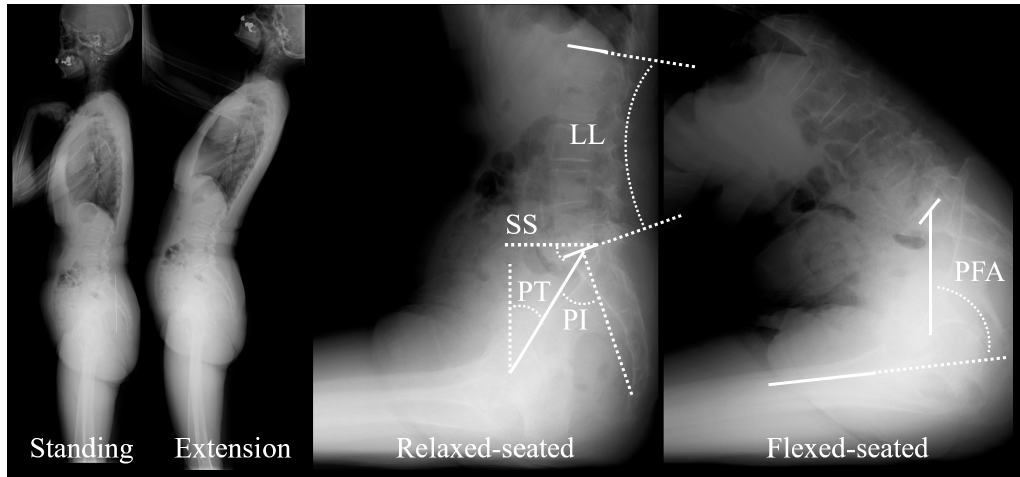
Figure 1. Lateral radiographs in free standing (Standing), standing with extension (Extension), relaxed-seated and, flexed-seated positions. Main radiological parameters are reported: sacral slope (SS), pelvic tilt (PT), pelvic incidence (PI), lumbar lordosis (LL), and pelvic-femur angle (PFA). The following standard parameters were measured by an experienced operator in all radiographs: sacral slope (SS), pelvic tilt (PT), pelvic incidence (PI), L1-S1 lumbar lordosis The dynamic spine-pelvis-hip motion was divided into three mobilities: pelvic, hip and (LL), pelvic incidence minus lumbar lordosis (PI-LL) and pelvic-femur angle (PFA) lumbar mobility. Pelvic mobility was defined as the difference in SS between the standing [11,17]. and sitting positions, and it was classified as stiff ( ∆ SS standing/relaxed-seated ≥ − 10 ◦ ), normal ( − 10 ◦ > ∆ SS standing/relaxed-seated > − 30 ◦ ), or hypermobile ( ∆ SS st, ing/relaxed-seated , ≤ , − 30 ◦ , ) [5]. Hip mobility was defined as the difference in PFA between the standing and sitting posi- tions ( ∆ PFA standing/sitting ). Lumbar mobility was classified according to the change in LL be- tween standing position and flexed-seated position as stiff ( ∆ LL standing/flexed-seated > − 20 ◦ ), flexible ( − 20 ◦ ≥ ∆ LL standing/flexed-seated > − 40 ◦ ) or hypermobile ( ∆ LL standing/flexed-seated ≤ − 40 ◦ ) [8]. The PI-LL mismatch was measured in the standing position and it was used